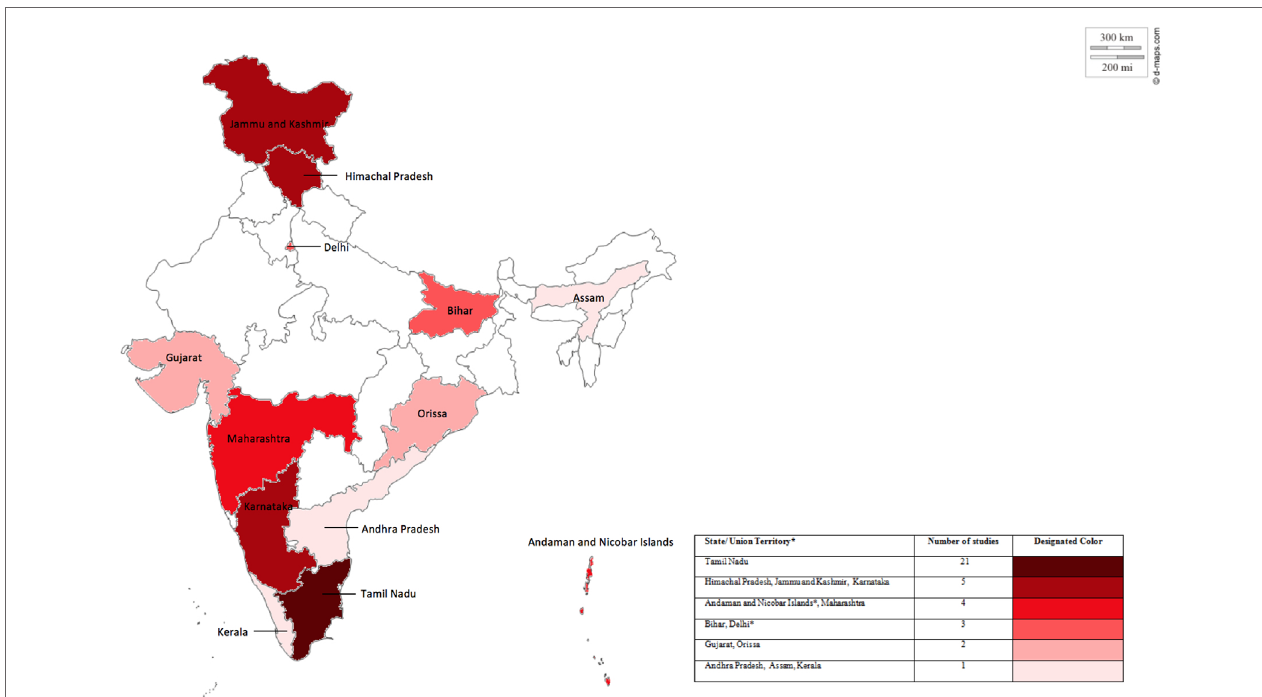
FIGURE 2 | State and union territory coverage, color coded according to number of studies covered per state or union territory. Figure a modification from an original map of India derived from: